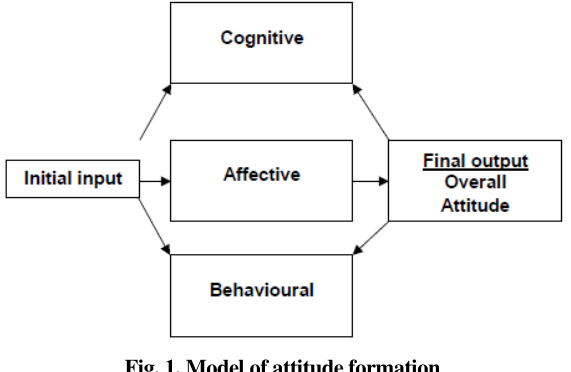
Fig. 1. Model of attitude